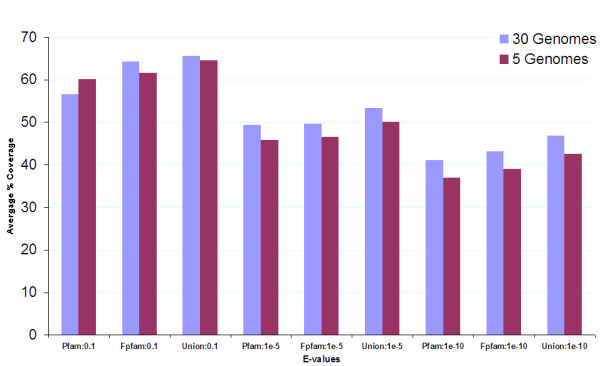
Effect of different E-value cut-offs on sequence coverage. The average percentage of sequences with at least one identified domain for the 30 original and five new fungal genomes is shown, for three different E-value cut-offs: 1e-1, 1e-5 and 1e-10. The percentage coverage using the FPfam library is higher than using Pfam alone. The best results are obtained when the outputs from the Pfam and FPfam library are combined.